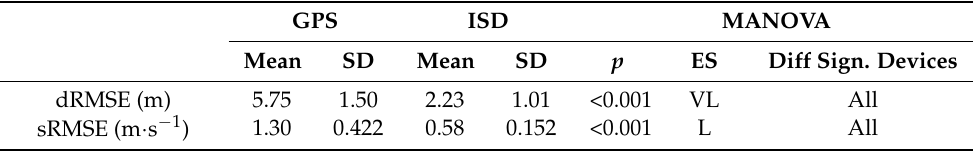
Table 2. Descriptive measures for distance error dRMSE related to GPS and ISD.